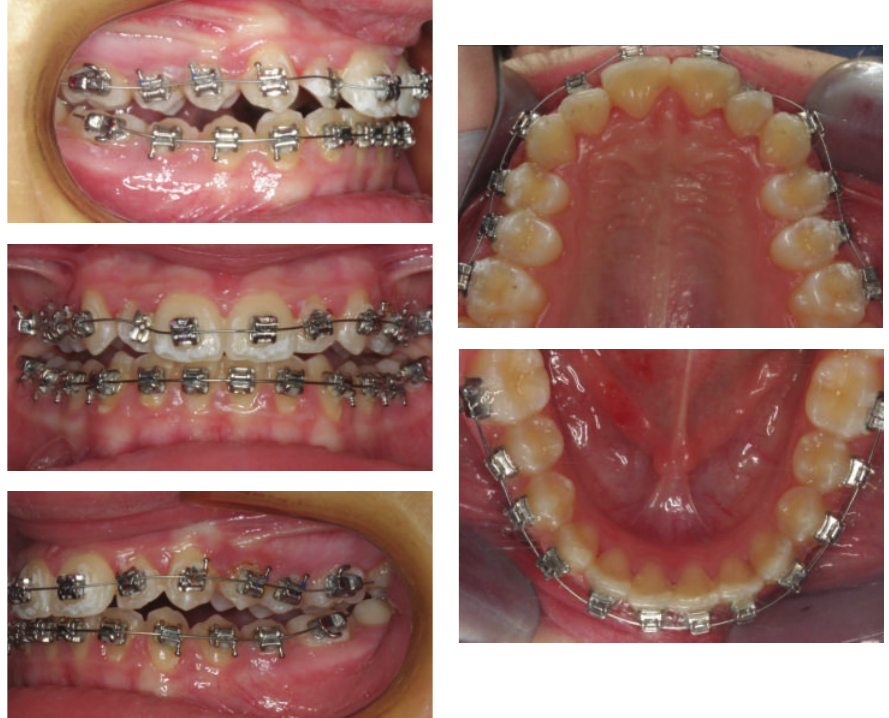
Figure 5: Intraoral photos with fixed appliances placed on both arches after a 10-month period in treatment.